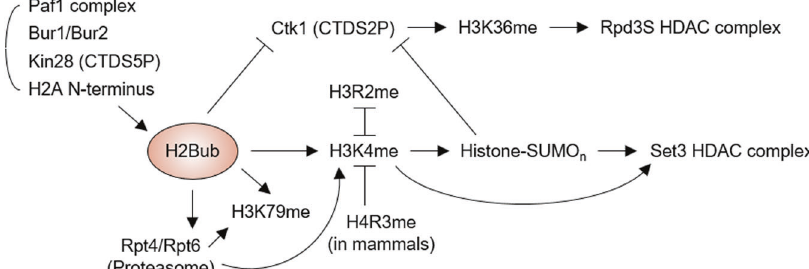
Fig. 1 H2B monoubiquitination-centered crosstalk pathway in S. cerevisiae. The Paf1 complex, Bur1/Bur2 and Kin28 kinases, and N-terminal tails of H2A facilitate H2B monoubiquitination (ub) during yeast transcription. H2Bub then promotes H3K4 and H3K79 methylation (me) both directly and via the proteasomal ATPases Rpt4 and Rpt6. H3R2me mutually antagonizes H3K4me, whereas H4R3me interferes with the binding ability of H3K4 methyltransferase (no reports of H4R3me in S. cerevisiae ). Although either H2Bub- or H3K4me-stimulated histone